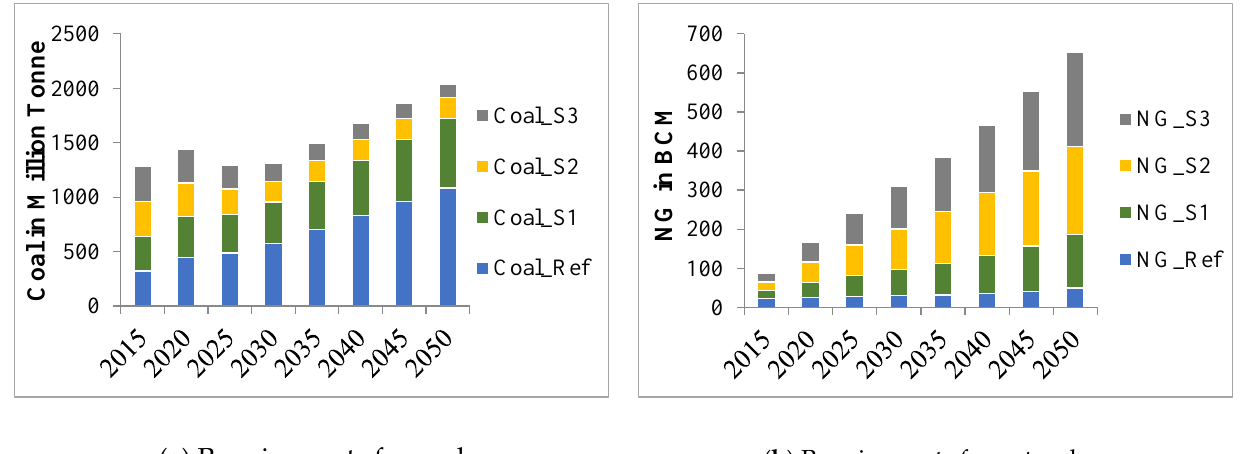
Figure 5. Requirements for coal and natural gas under different scenarios.